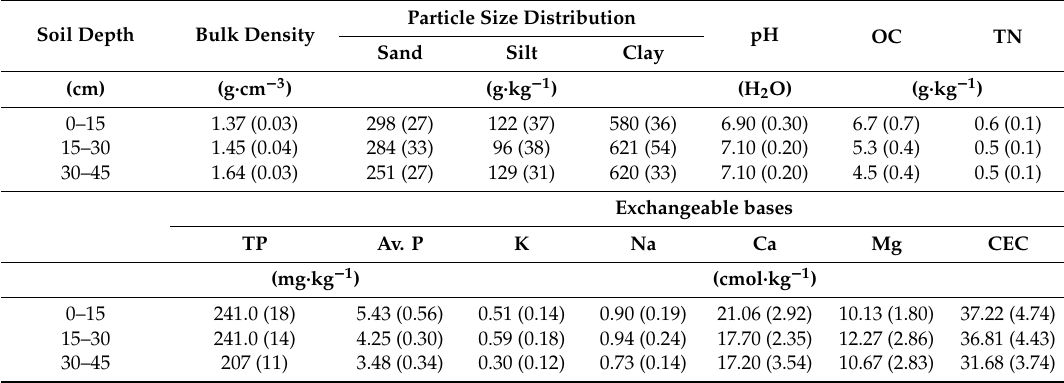
Table 3. Physico–chemical Properties of the soil used for the experiment.